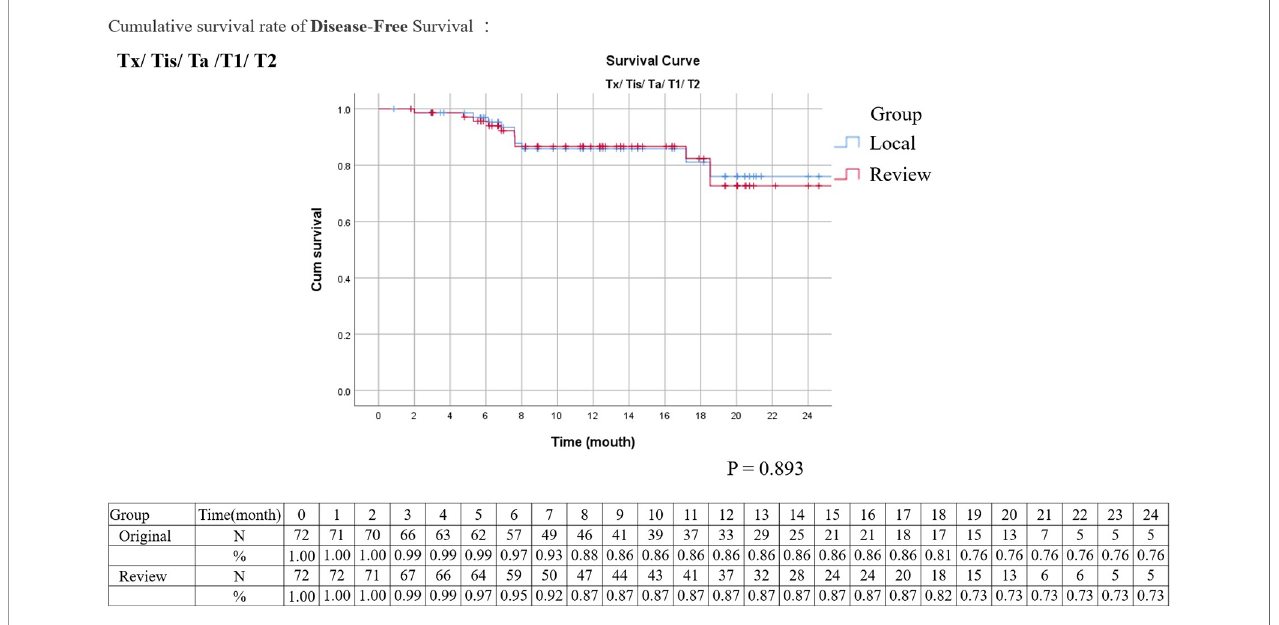
FIGURE 1 | Kaplan – Meier survival curves of disease-free survival strati fi ed by original or review pathology in localized upper tract urothelial cancers (survival curves were created and analyzed by SPSS software version